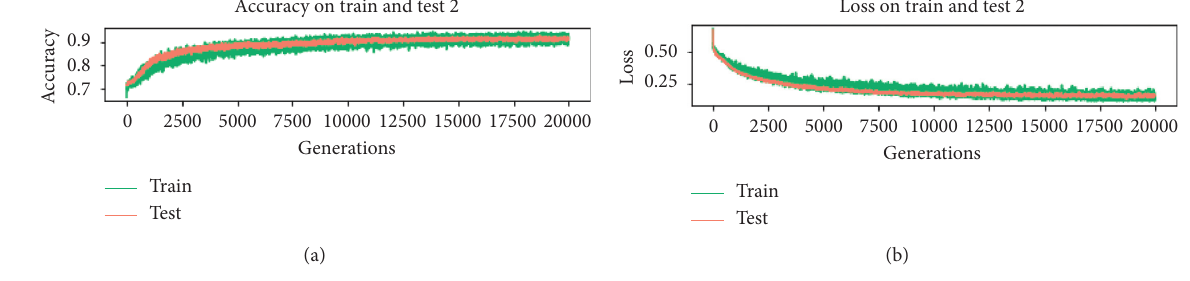
Figure 13: The accuracy (a) and the loss (b) for once shrunk time window.